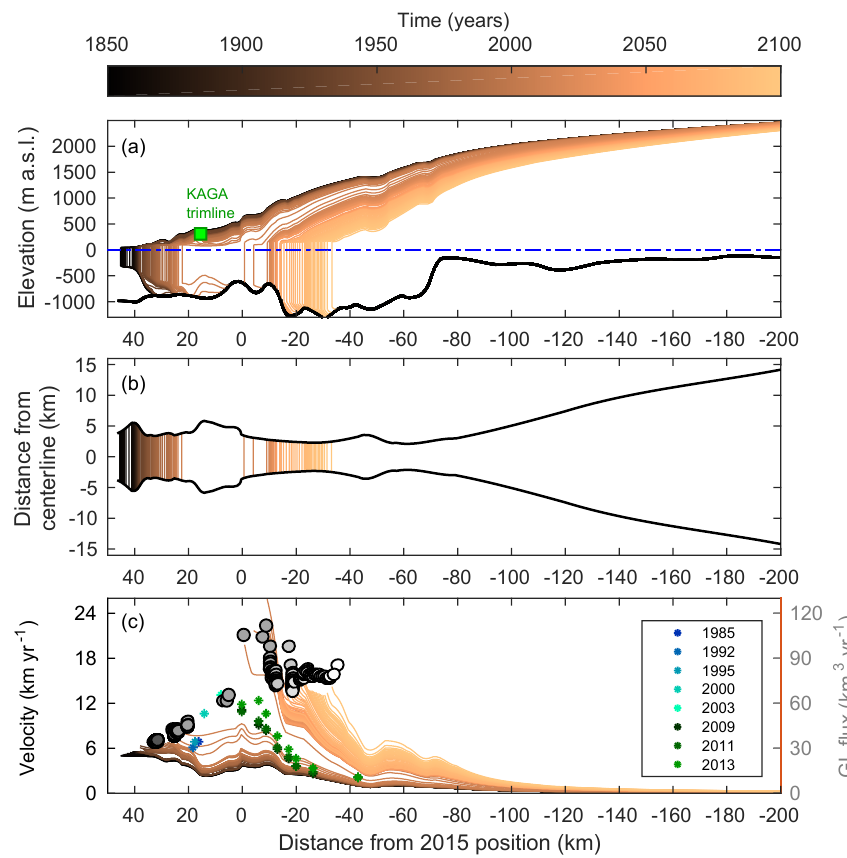
Figure 4. Modeled retreat of Jakobshavn Isbræ in response to a gradual change of the forcing parameters (run 5 in Table 2). Yearly profiles are shown for (a) the along-flow glacier profile and the elevation of the KAGA LIA trimline (Csatho et al., 2008) in green, (b) the front positions in a top view and (c) the along-glacier annual velocities including the yearly grounding line (GL) flux (gray circles from dark to light with time). Observed yearly velocities are plotted at the calving front from 1985 to 2003 (Joughin et al., 2004) and at seven different points upstream from the glacier front from 2009 to 2013 (Joughin et al.,